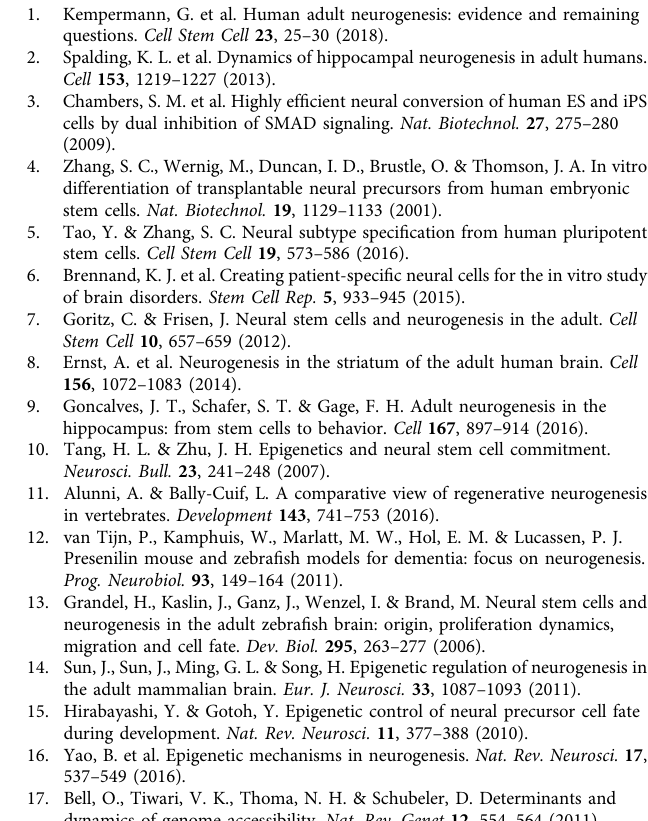
Fig. 7 BAF53B rescues the differentiation defect in JMJD3/UTX-de fi cient human NPCs. a Upper panel, qRT-PCR and western blot analysis of BRG1 and BRM in the indicated ESCs, NPCs, and their differentiated cells at day 28. Bottom panel, western blot analysis of BRG1 and BRM in the indicated differentiated wild-type (WT) or dKO cells at day 28 with the proteasome inhibitor MG132. The data represent the mean ± SD (standard deviation) from three independent replicates ( n = 3). npBAF, neural progenitor cell-speci fi c BAF complex. nBAF, neuron-speci fi c BAF complex. dKO, deletion of both JMJD3 and UTX. b qRT-PCR and immuno-staining analysis of the npBAF component BAF53A in the indicated ESCs, NPCs, and their differentiated cells